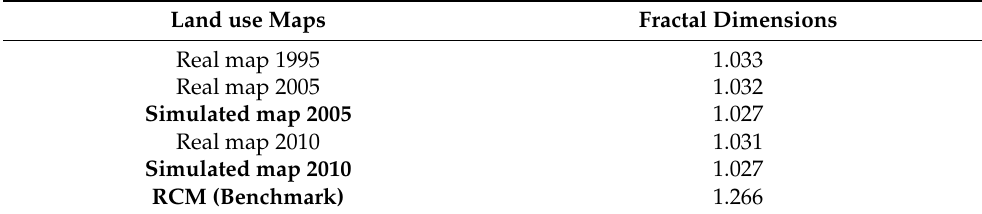
Table 4. Results from evaluating the process accuracy of the